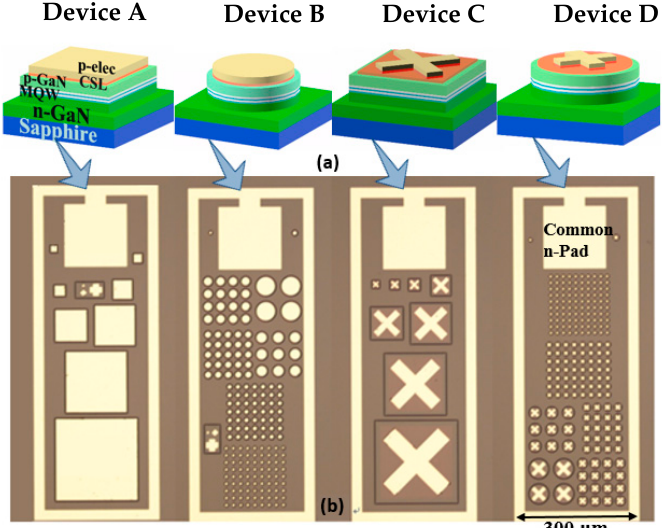
Figure 2. ( a ) Three-dimensional views of micro-LEDs; ( b ) microscope photos of the device dies of different sizes and structures (from left to right: bottom emitting single pixels, bottom emitting pixel array, top emitting single pixels and top emitting pixel array).